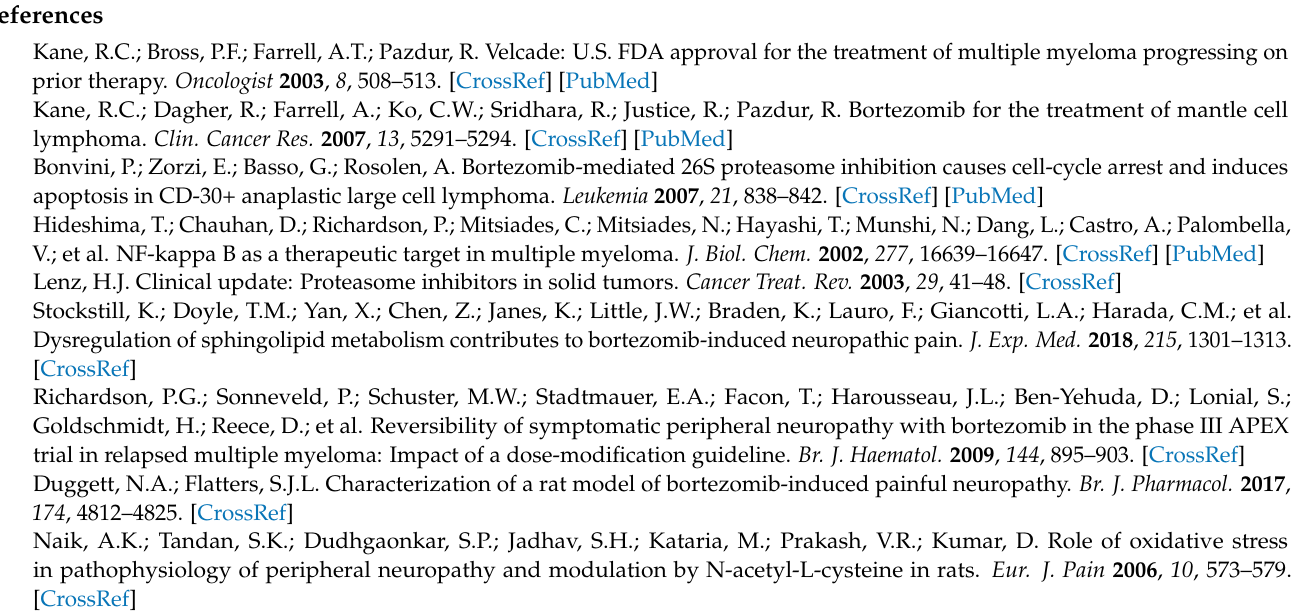
Table S4: Significantly enriched GO terms in molecular function, Table S5: Analysis of transcription factor motif enrichment